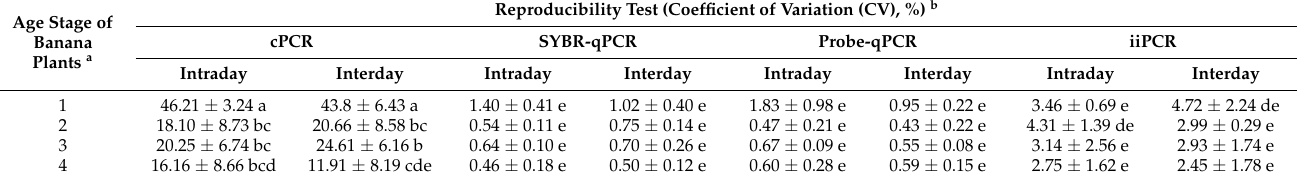
Table 5. Reproducibility evaluation of the molecular detection assays used to detect Fusarium oxysporum infection of banana plants at different age stages with mild symptoms used as